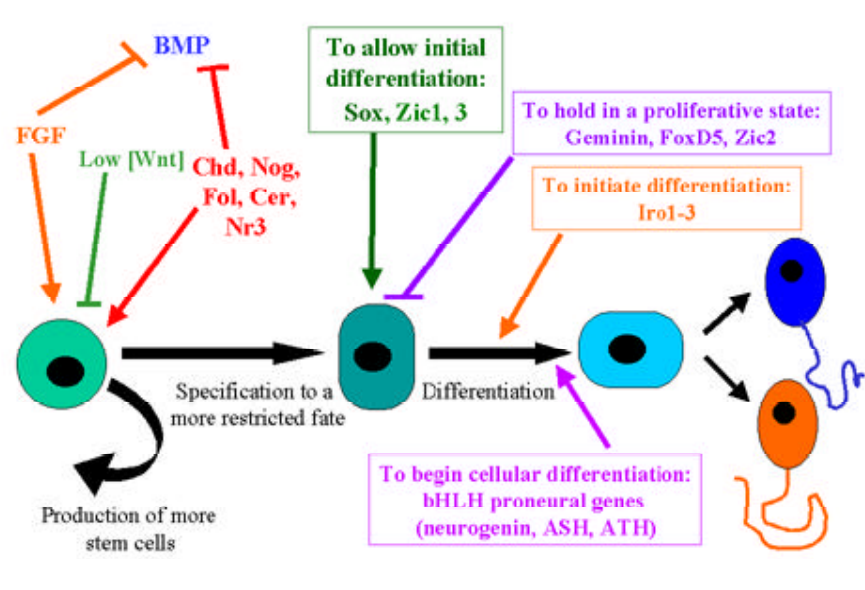
FIGURE 4. A proposed scheme for what genes might need to be activated, based on the study of normal neurogenesis reviewed in this article, to produce neural-fated stem cells and to expand those cells prior to